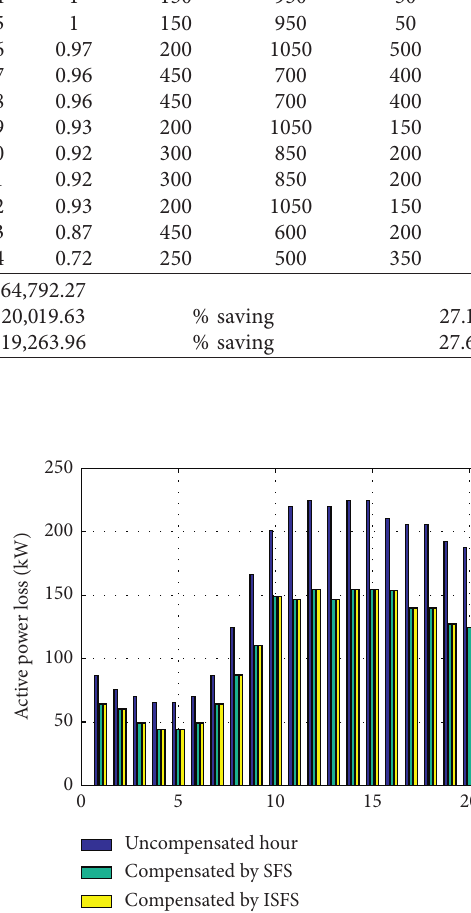
Figure 14: Power losses of 69-bus network within 24-hour interval before and after compensation in scenario